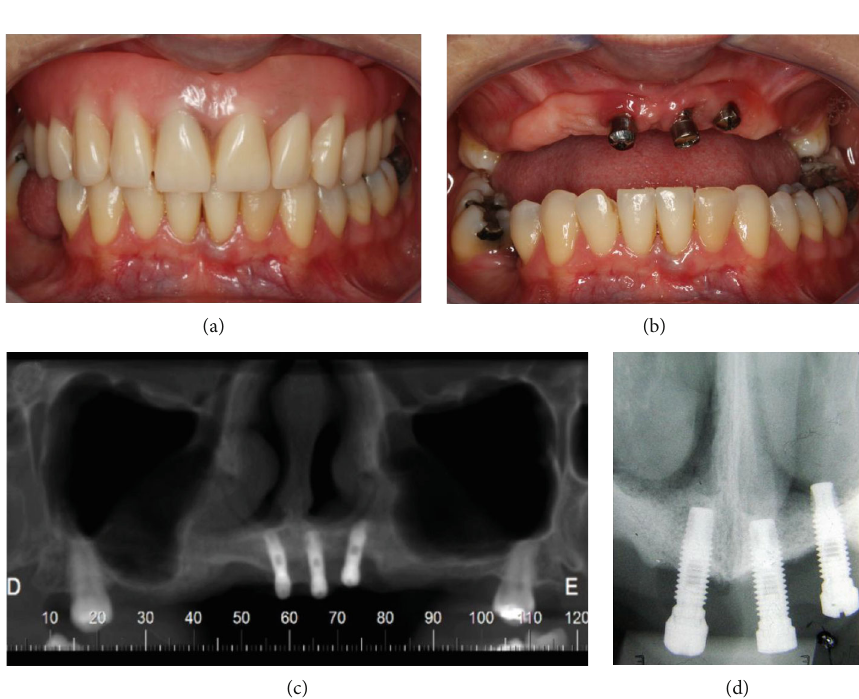
Figure 2: Intraoral images of the prosthesis in placement (a). After prosthesis removal, it is possible to observe gingival in fl ammation and swelling of the implants (b). Panoramic and periapical radiographies show evident bone resorption around the implant threads and severe pneumatization of the maxillary sinuses (c,